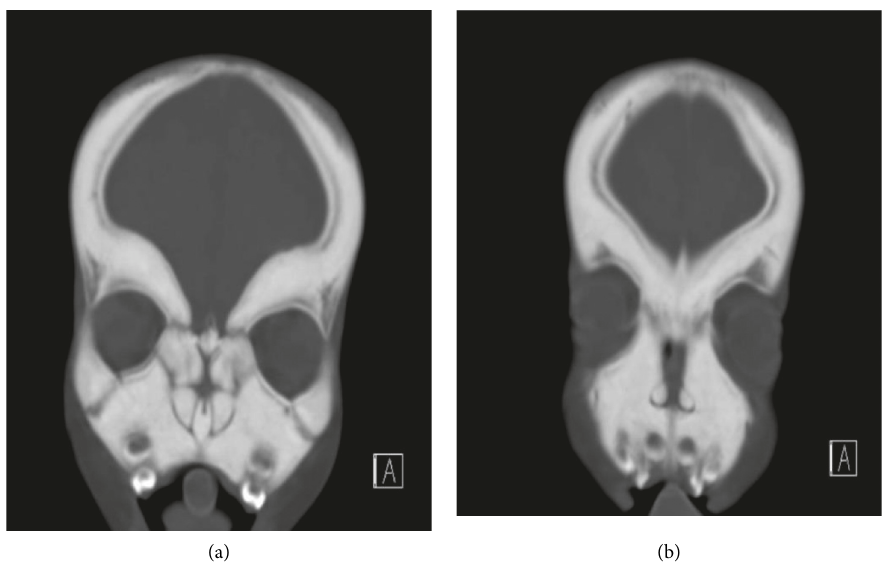
Figure 4: The CT scan of the brain shows extensive thickening of the facial bone.